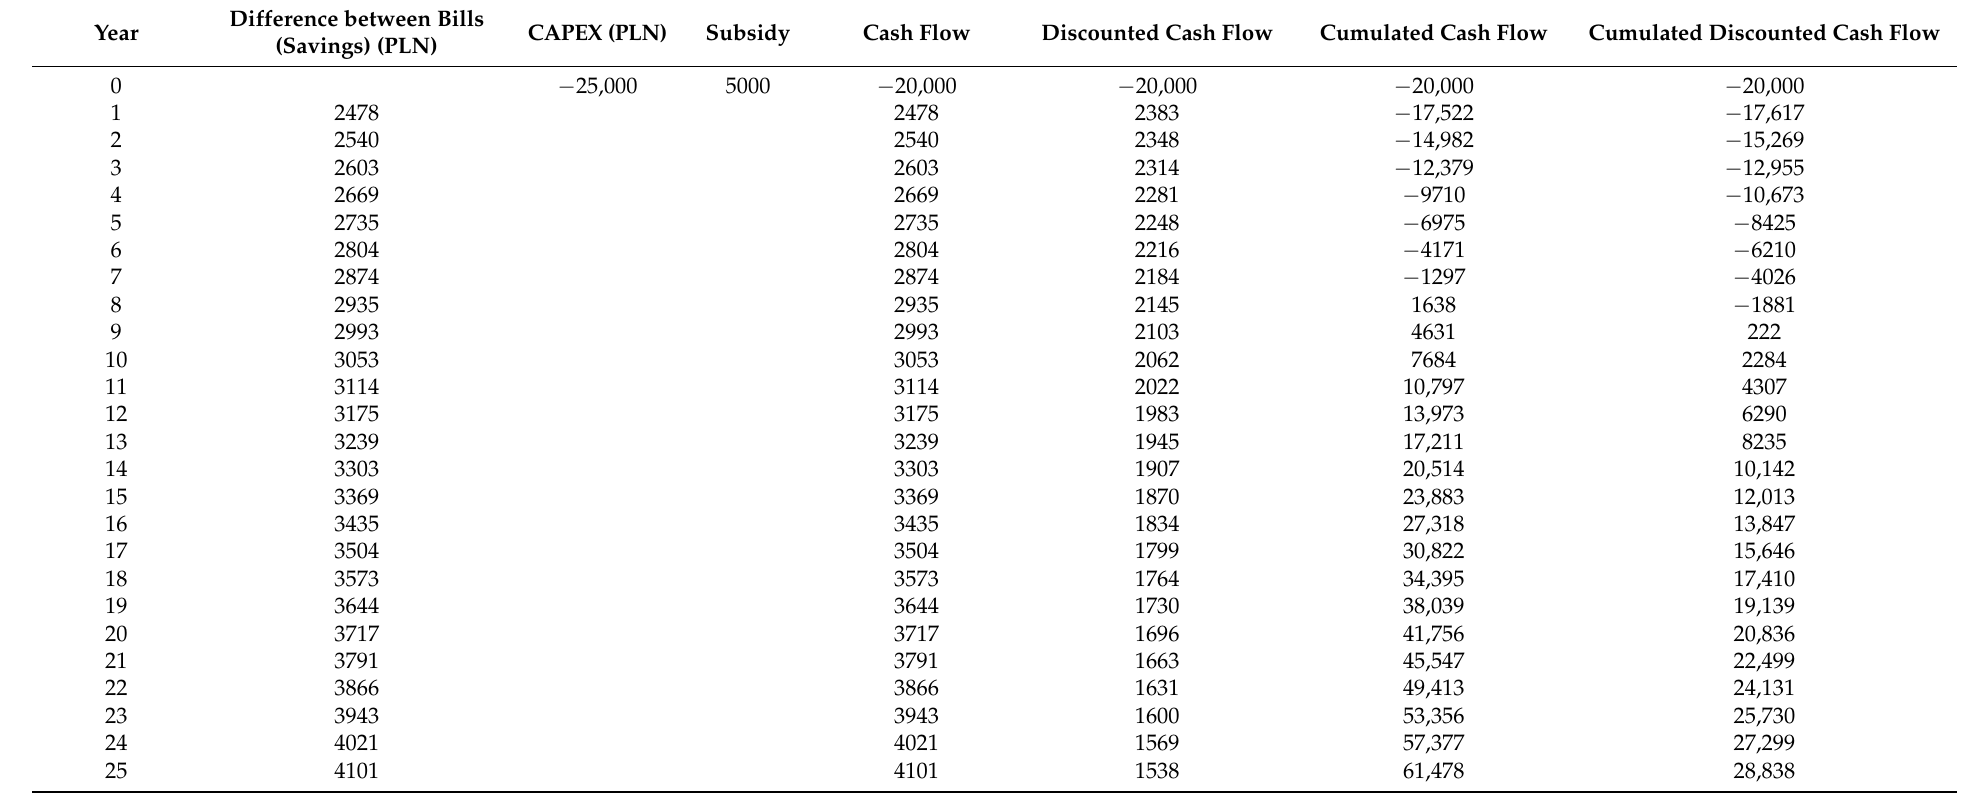
Table A2. Cash flows for net-metering